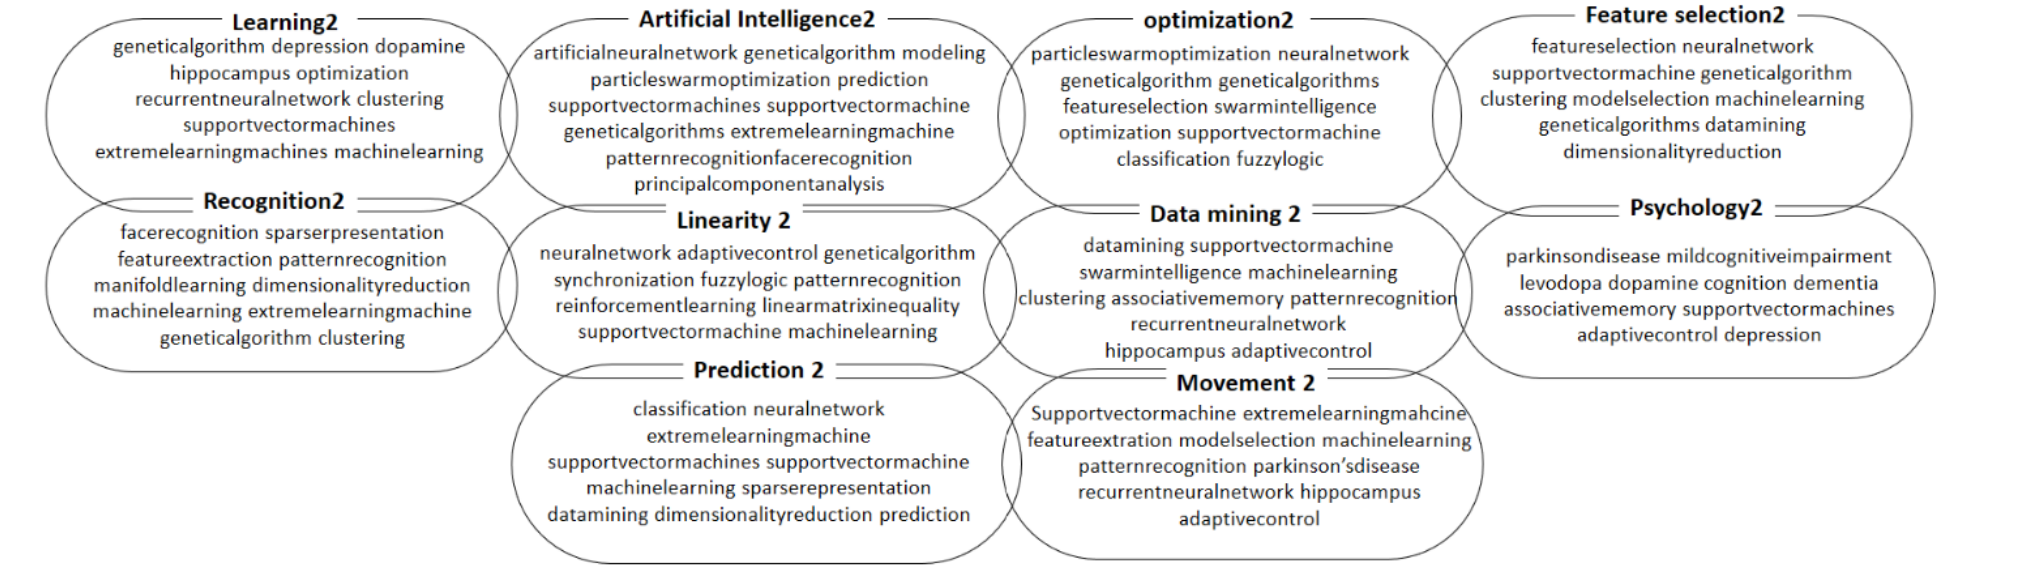
Figure 7. The ten clusters for the period from 2012 to